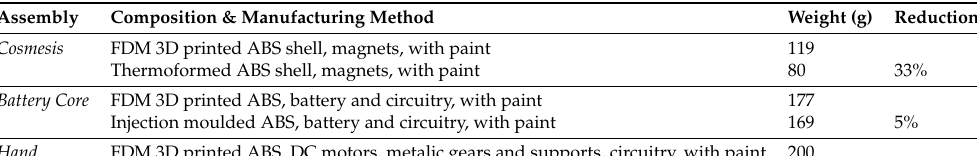
Table 1. Evaluating in-house prosthesis assembly, comparing manufacturing methods for components and the resulting